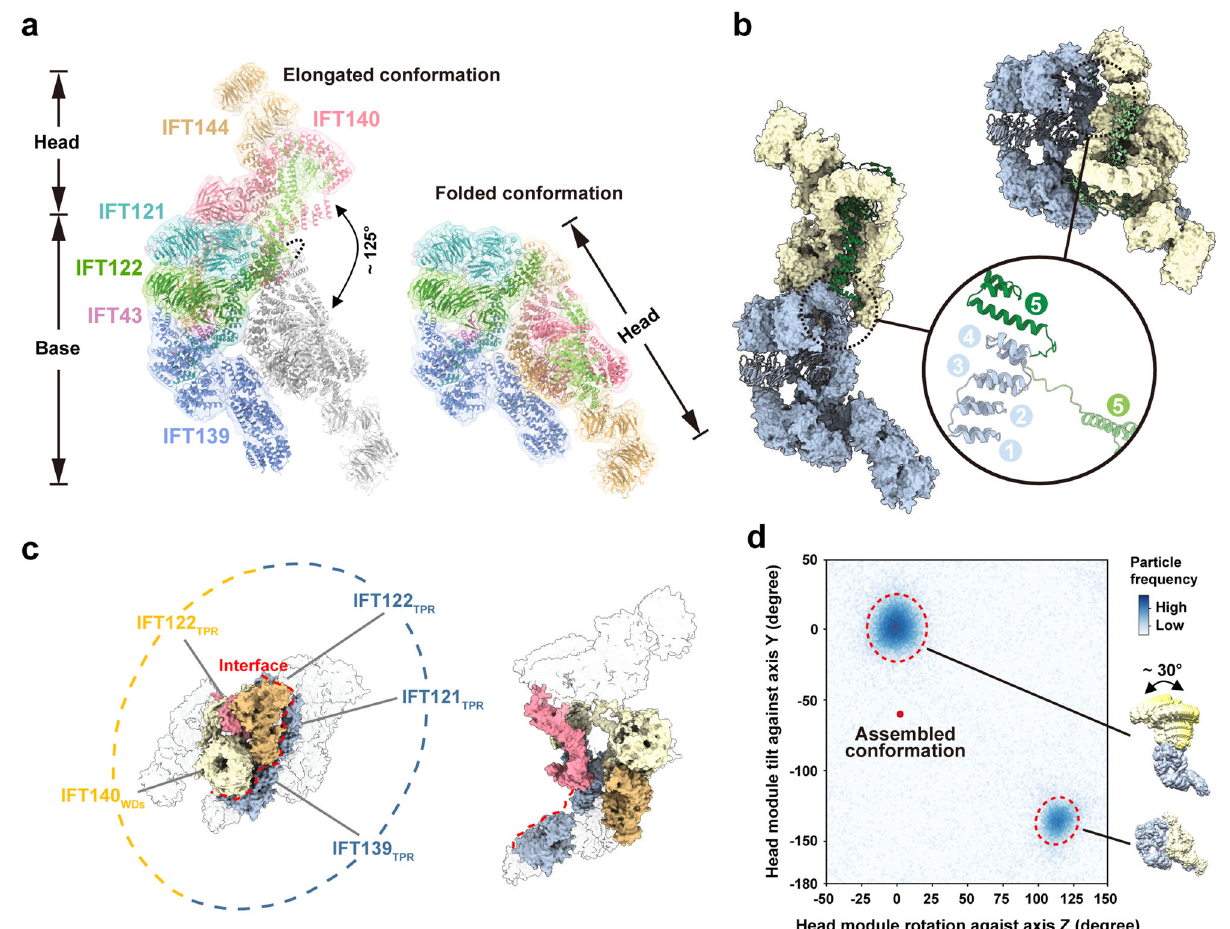
Fig.3|StructuralcomparisonoftheelongatedandfoldedstatesofIFT-A.a The atomic models of the elongated (left) and folded (right) states of IFT-A. IFT-A proteins are colored same as Fig. 1a. The folded state is superimposed onto the elongatedstatebasedonthestructureofthebasemodulewhileitsheadmoduleis colored in gray. b Comparison of the TPR arm of IFT122 inthe two states. IFT122is colored as Fig. 1a while the remaining portion of IFT-A colored as Fig. 1e. Super- position of the bending site of IFT122 in the two states. The fi rst four TPRs are colored in pale blue while the fi fth TPR and Loop-45 colored in green in the